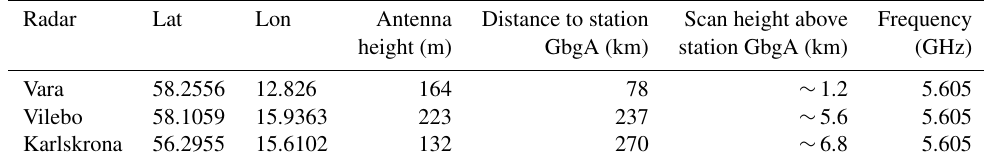
Table 3. Characteristics of radars contributing to the NORDRAD